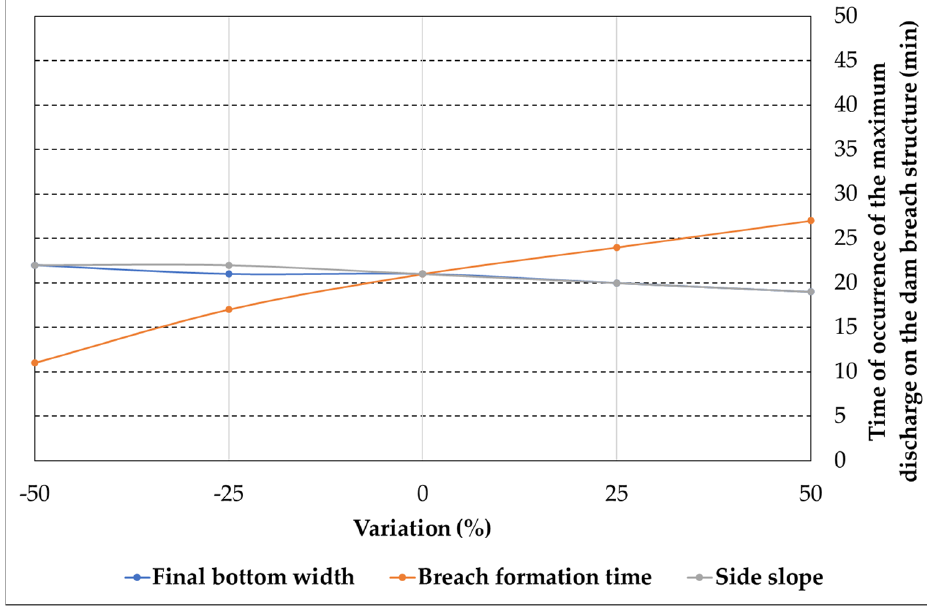
Figure 11. Time of occurrence of the maximum discharge on the dam breach for varying breach parameters.